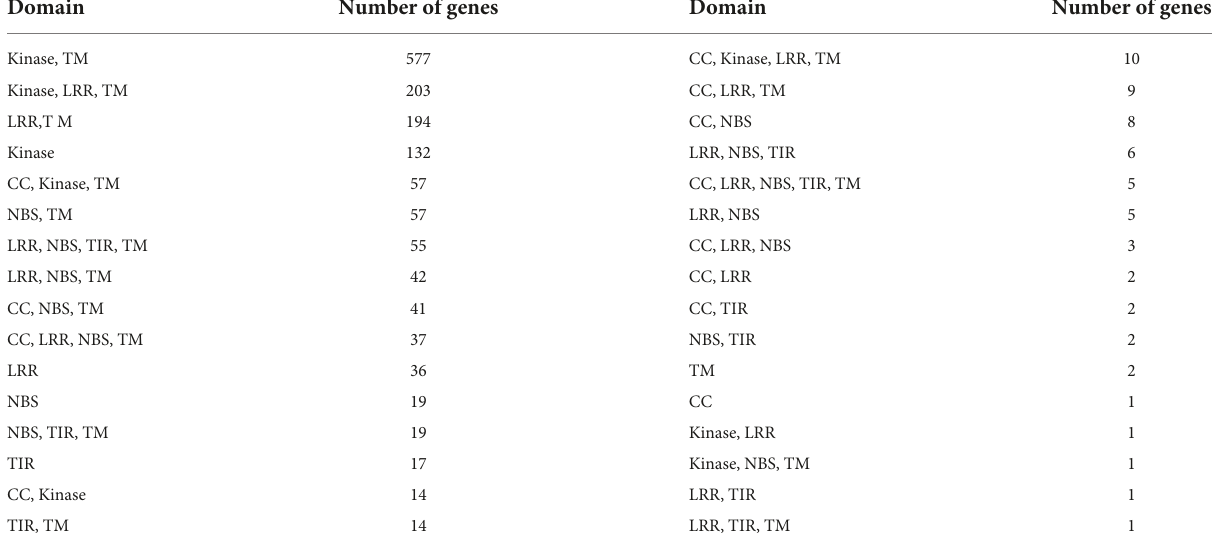
TABLE 5 Disease resistance genes identified in ‘Bhagawa’.